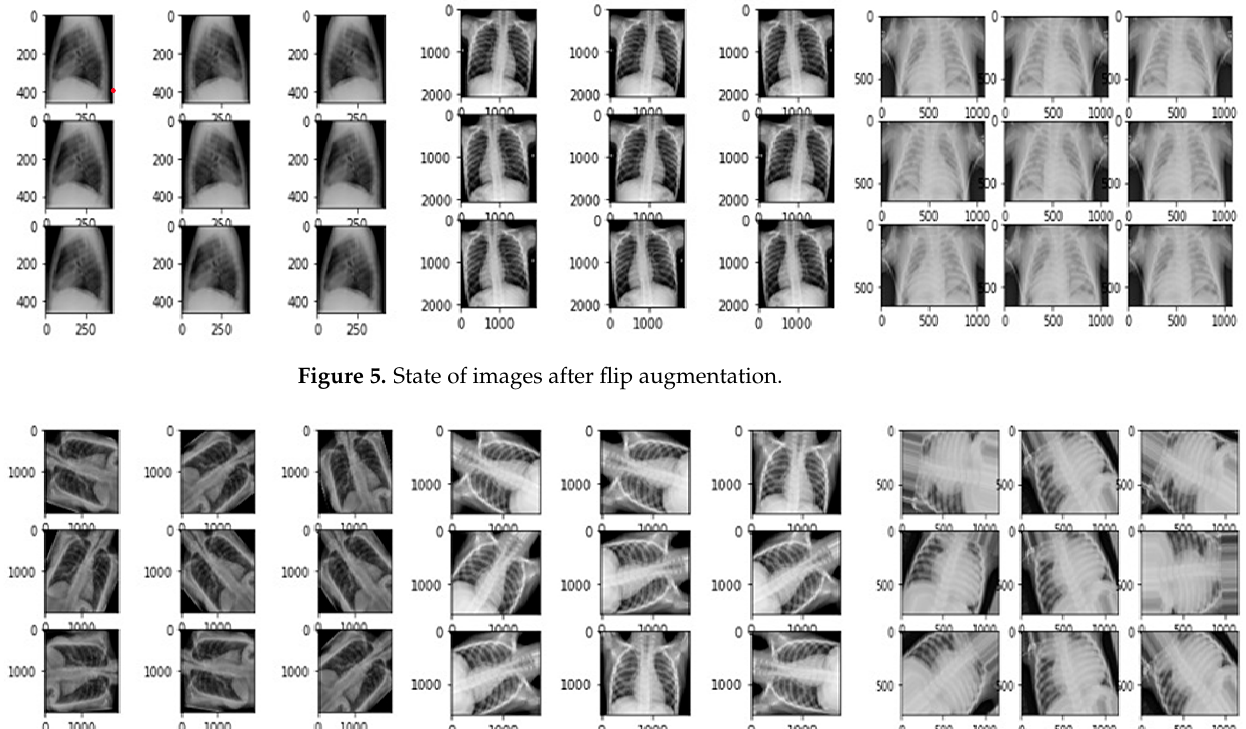
Figure 4. Proposed framework for COVID-19 detection using imagery data.